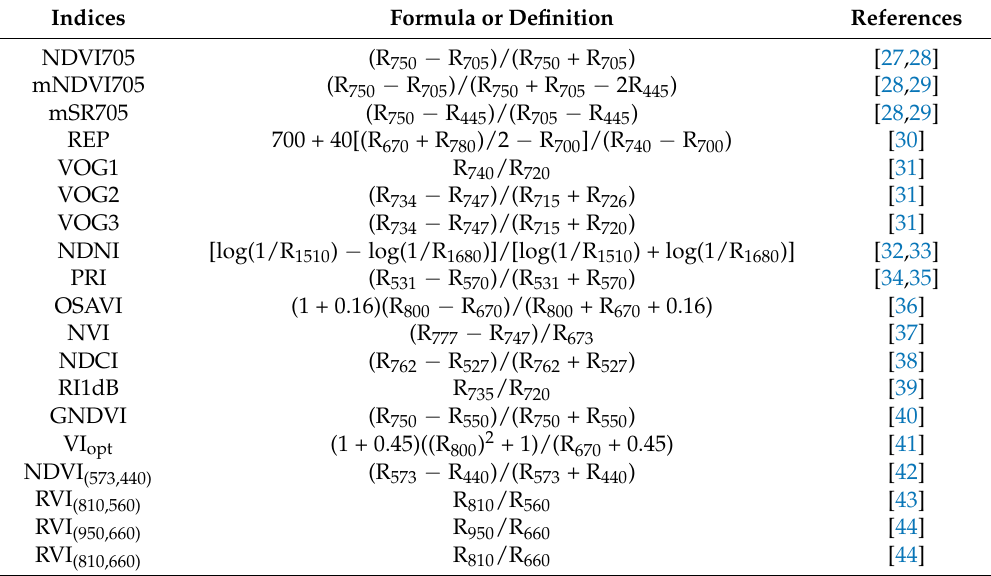
Table 2. Hyperspectral indices for nitrogen content